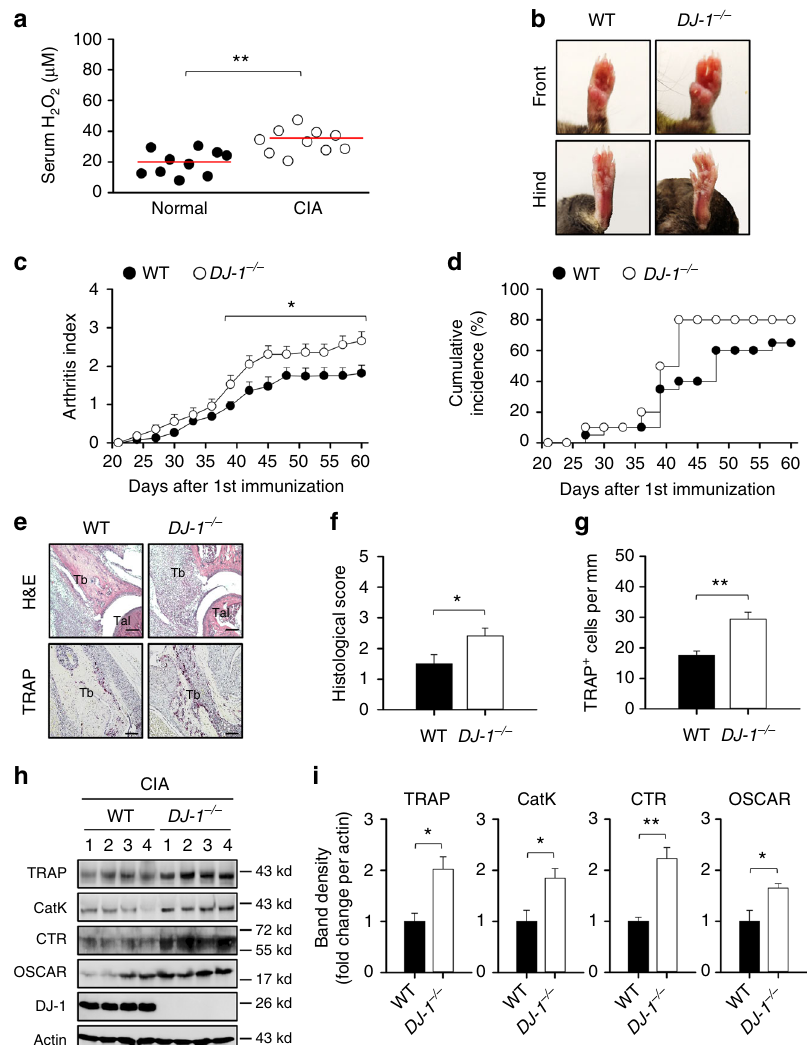
Fig. 7 DJ-1 de fi ciency exacerbates collagen-induced arthritis in mice. a Sera from normal or CIA-induced C57BL/6 mice was measured by using ELISA ( n = 10). b Representative images of front (upper) and hind (lower) paws of CIA-induced WT and DJ-1 − / − mice. c Arthritis index values and d cumulative incidence are shown ( n = 20). ** p < 0.01 vs. corresponding values of WT mice by Mann − Whitney test for c . e – g Paraf fi n sections were prepared from CIA mouse ankle tissues stained with H&E (upper) and TRAP (lower) from experiments as in b (Tb: tibia, Tal: talus). Representative H&E and TRAP stained images e , histological scores f , and TRAP + cell count g are shown. Scale bar, 50 μ m. Representative immunoblot images h and band densities i for OC marker proteins of ankle tissues from experiments as in b ; n = 4. Representative images b , e , h or values c , f , g , i are represented as the mean ± s.e.m. ** p < 0.01, * p < 0.05 by Student ’ s t -test a , f , g ,